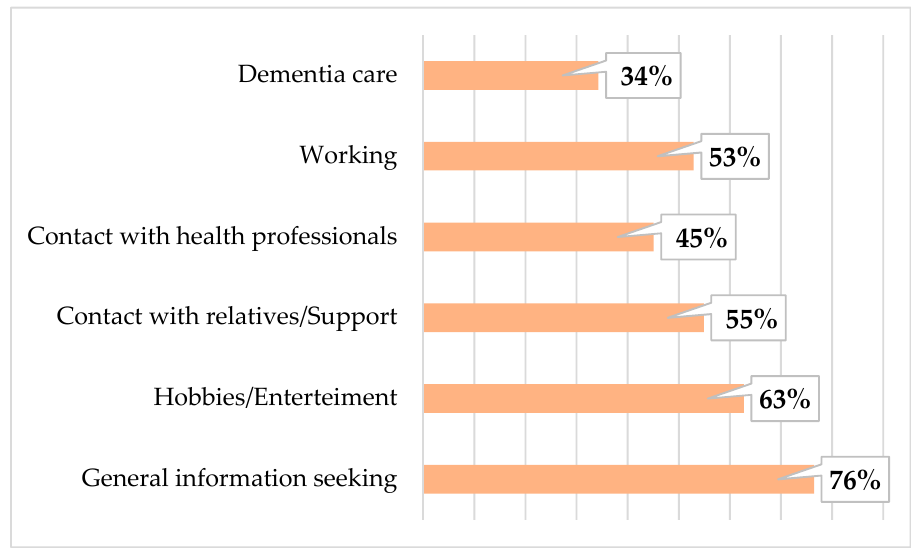
Figure 3. The purpose of computer use in caregivers.